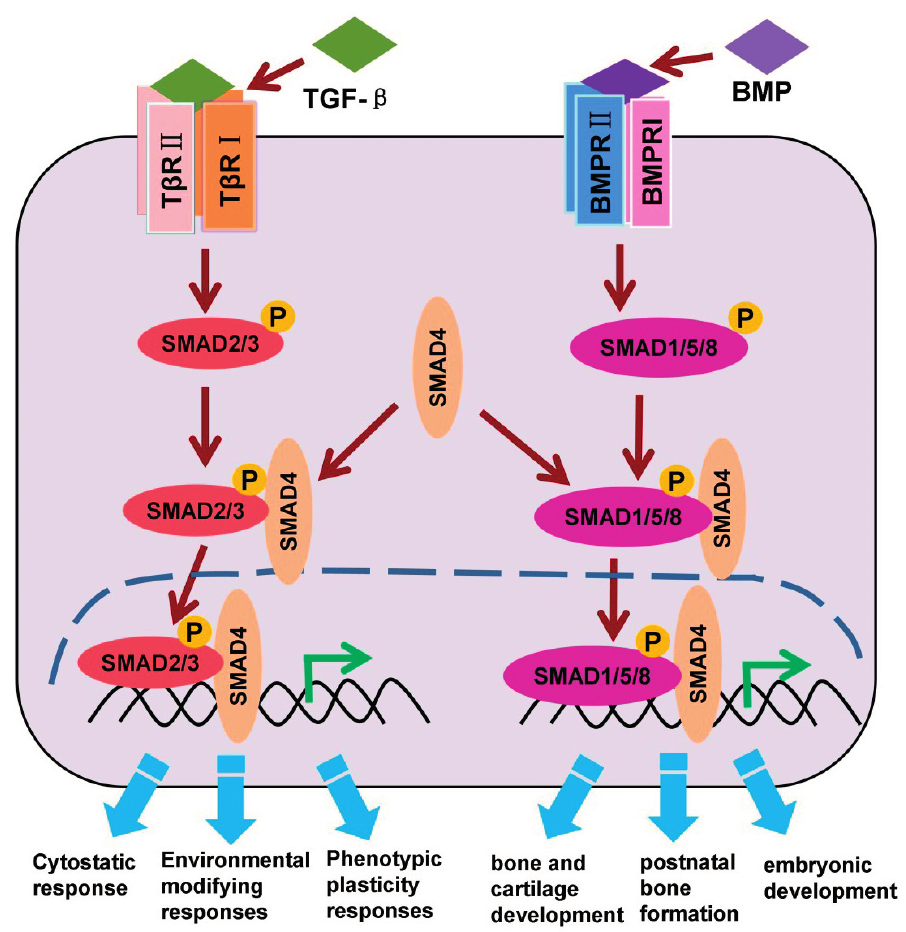
Figure 2. Schematic representation of TGF- β /SMAD and BMP/SMAD